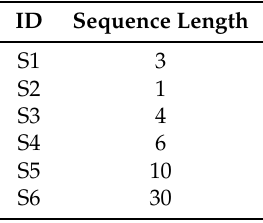
Table 2. Sequence-length experiments. Each experiment followed the same configuration used in A3 (see Table